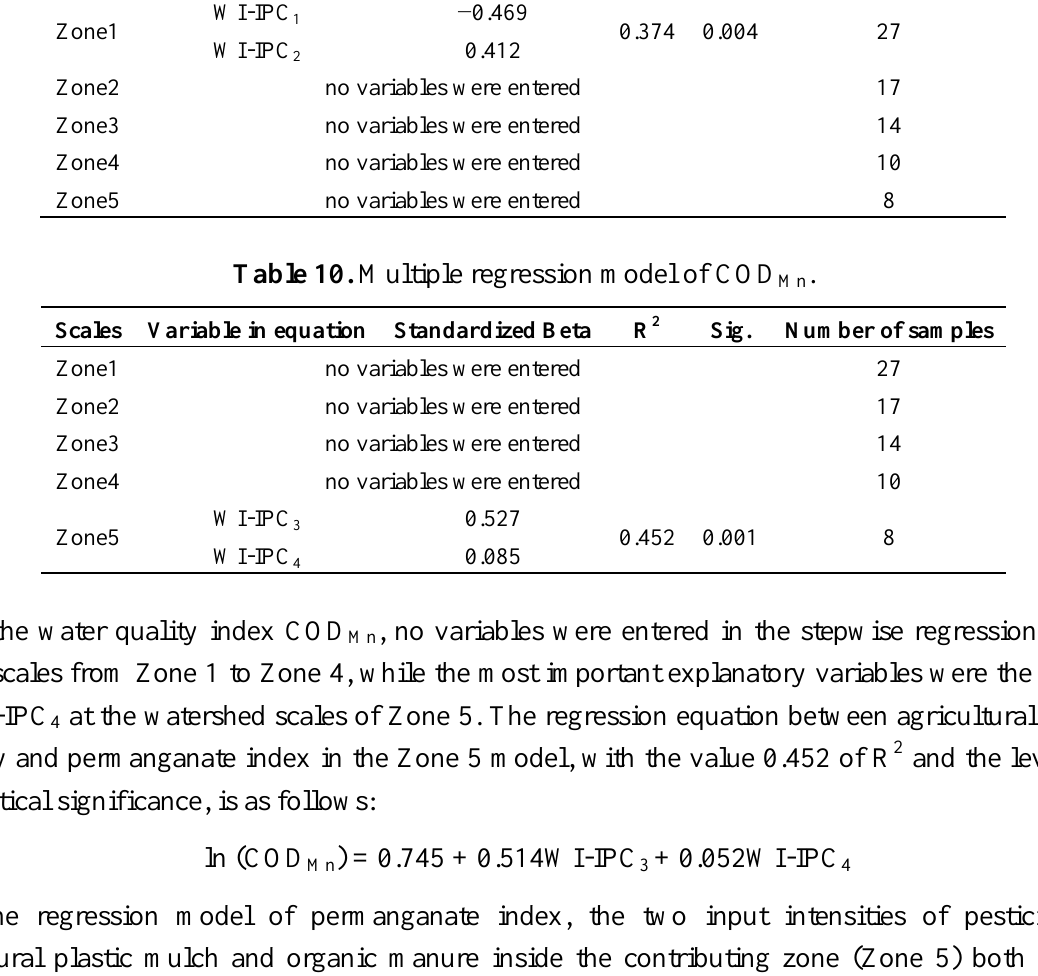
Table 9. Multiple regression model of NO